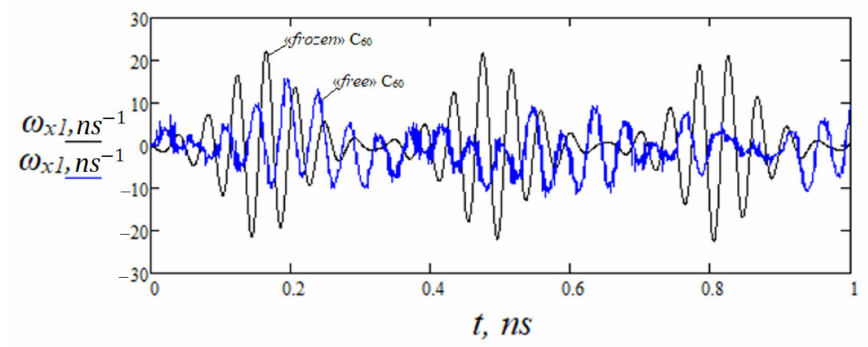
Figure 6. Distribution of the z -component of the angular velocity of the nanotorus.